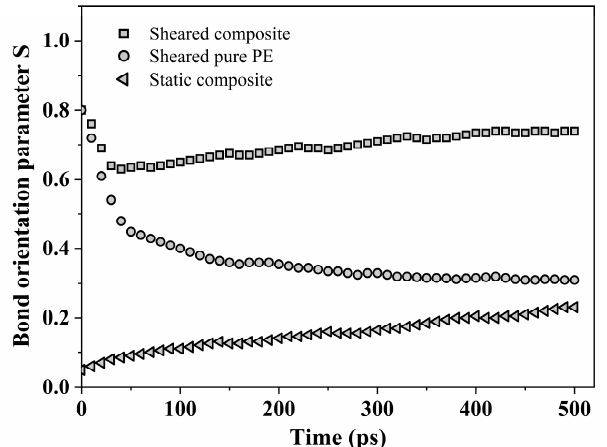
Figure 6. The change curve of the bond orientation parameters of PE molecular chains over time.